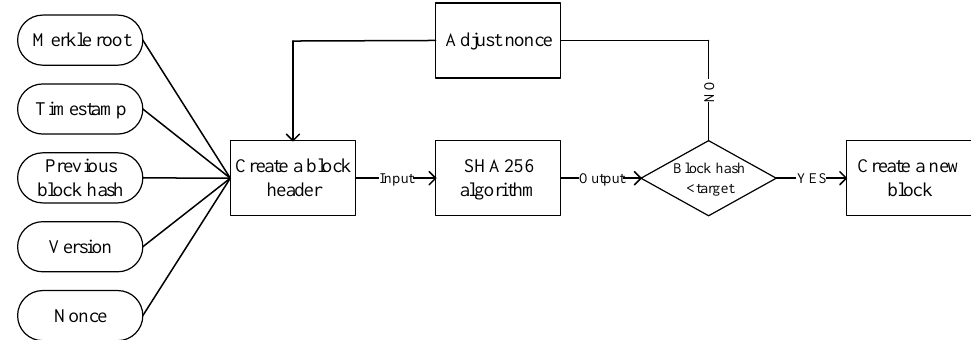
Figure 7. PoW Algorithm Flowchart.